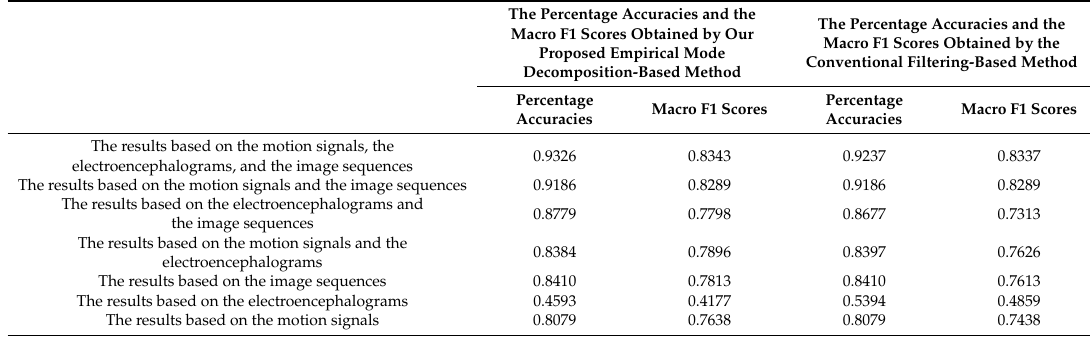
Table 3. The percentage accuracies and the macro F1 scores obtained by our proposed empirical mode decomposition-based method and the conventional filtering-based method using the signals acquired from the second volunteer.